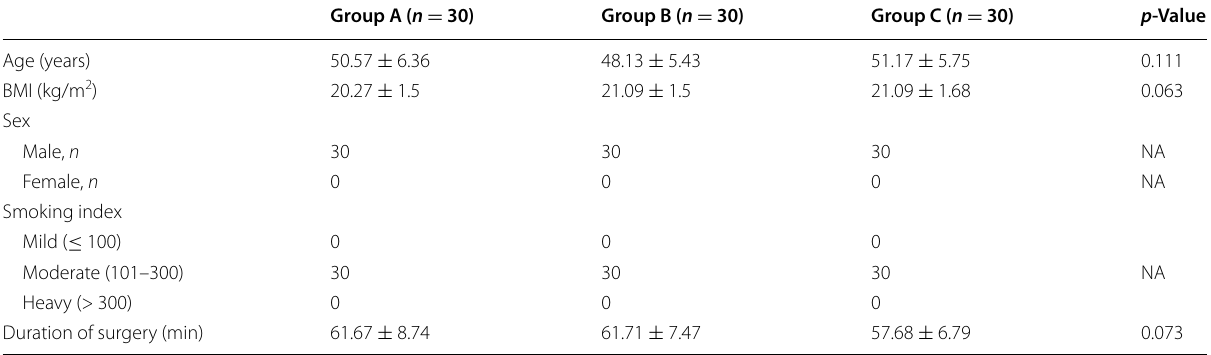
BMI Body mass index, min minutes, value of p < 0.05 is significant, NA Not applicable, n number